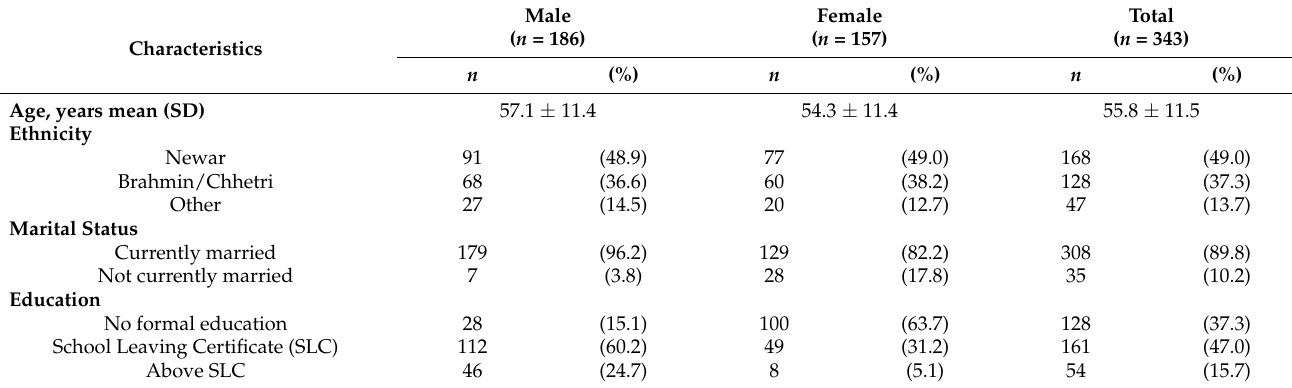
Table 1. Sociodemographic characteristics among 343 diabetes patients at Dhulikhel